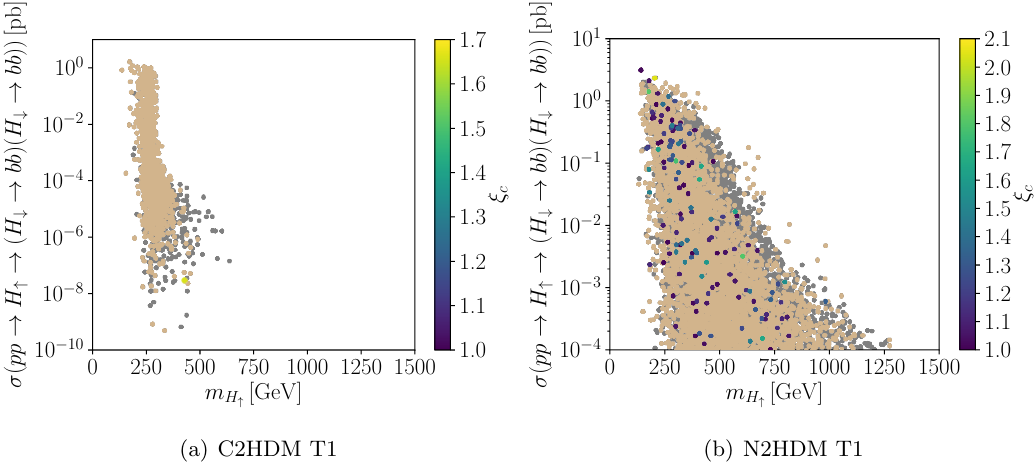
Figure 12 . T1: production rate of H " with subsequent decay into H # H # in the 4 b (cid:12)nal state versus m H for the C2HDM (left) and the N2HDM (right). The color code is the same as in (cid:12)gure 3. The " color bar indicates the strength of the phase transition for (cid:24) c are included.